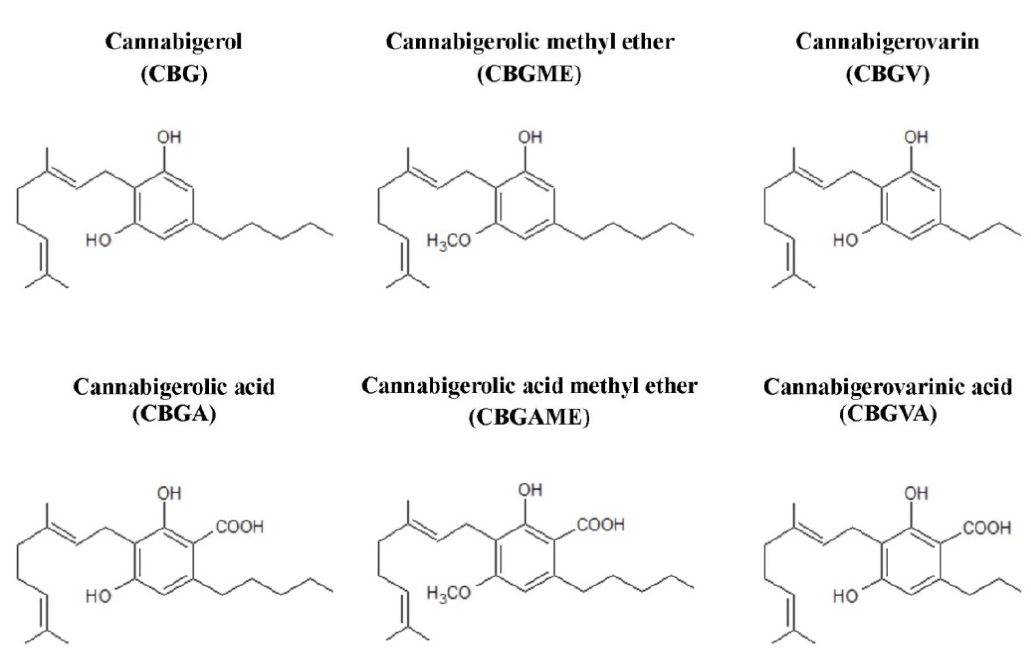
Figure 2. Chemical structures of main compounds from the group of cannabigerol-type phyto- cannabinoids.